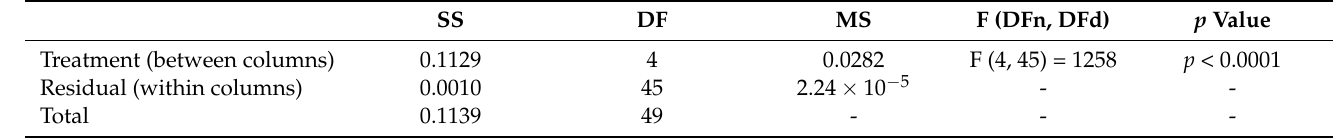
Table 5. Results of comparisons between proposed classifiers and those obtained from ANOVA.